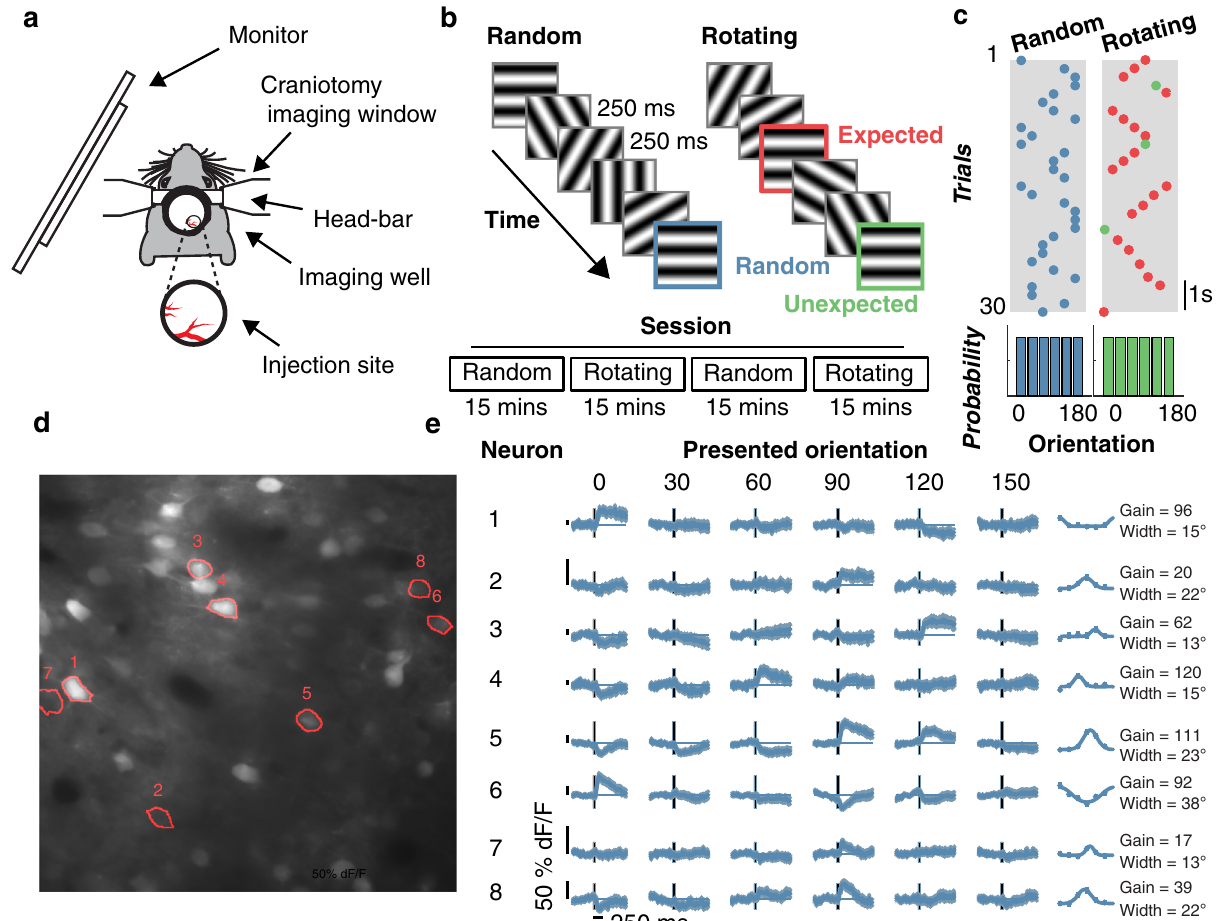
Fig. 1 | Experimental procedure for testing the effects of prediction on orien- tation selectivity in mouse V1 neurons. a Apparatus for using two-photon cal- cium imaging in combination with visual stimulation. b Schematic of the Random and Rotating sequences of oriented gratings. c In the Random condition, the orientation of each stimulus was drawn from a pseudo-randomised distribution (uniform probability from 0 to 150° in 30° steps). In the Rotating condition, the gratingsrotatedclockwise(e.g.,0°->30°->60°)oranti-clockwise(e.g.,0°->150°-> 120°) for 5 – 9 presentations (red dots) before jumping to a random unexpected orientation (indicated by the green dots). d Mean motion-corrected two-photon